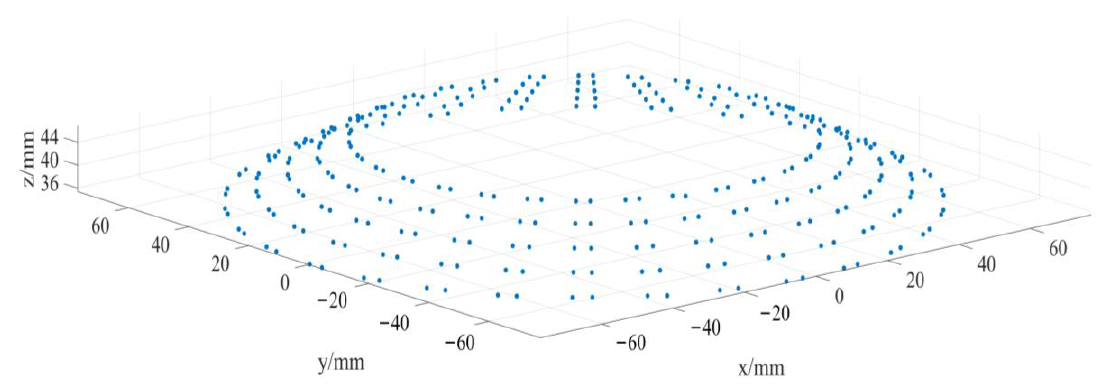
Figure 13. Calculated gear point coordinates.